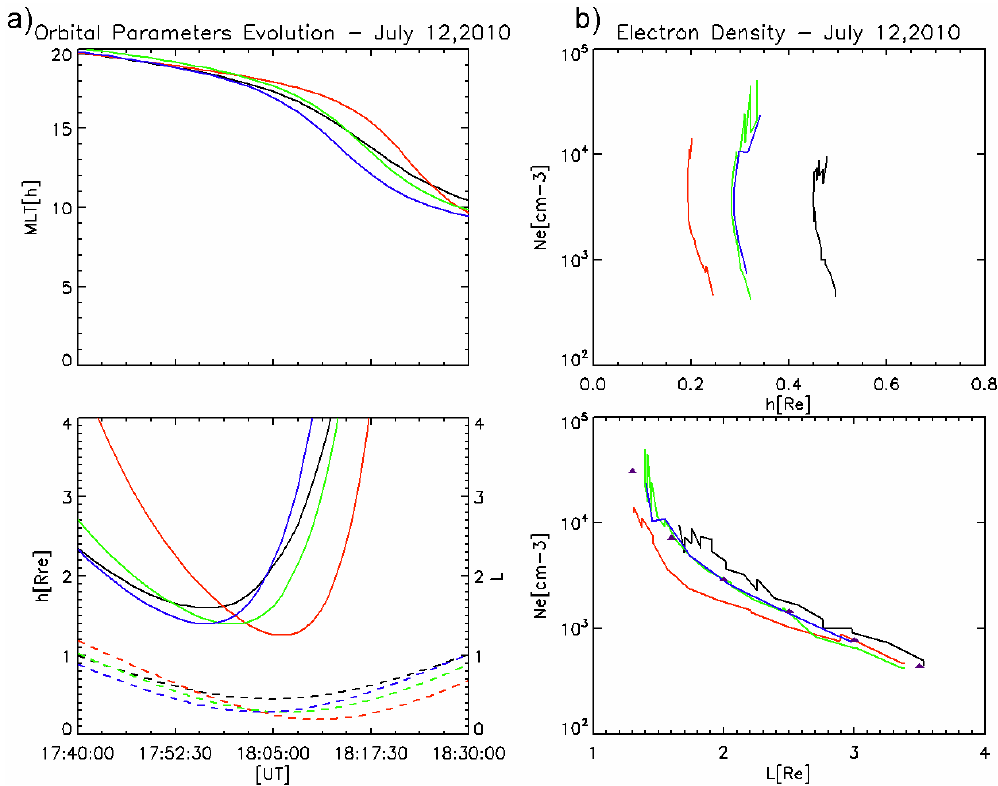
Fig. 7. (a) Evolution of orbital parameters, magnetic local time (upper panel) altitude (dashed lines) and L value (solid lines) (lower panel) for the event shown in Fig. 5. Colour codes according to satellite, black, red, green and blue respectively for C1, C2, C3 and C4. (b) Densities outbound of minimal L value encountered as function of altitude (top) and L value (bottom). M eff values used in the calculations are deduced from the inbound F lh measurements, 1.16, 1.26, 1.20, and 1.18 for C1, C2, C3 and C4, respectively.